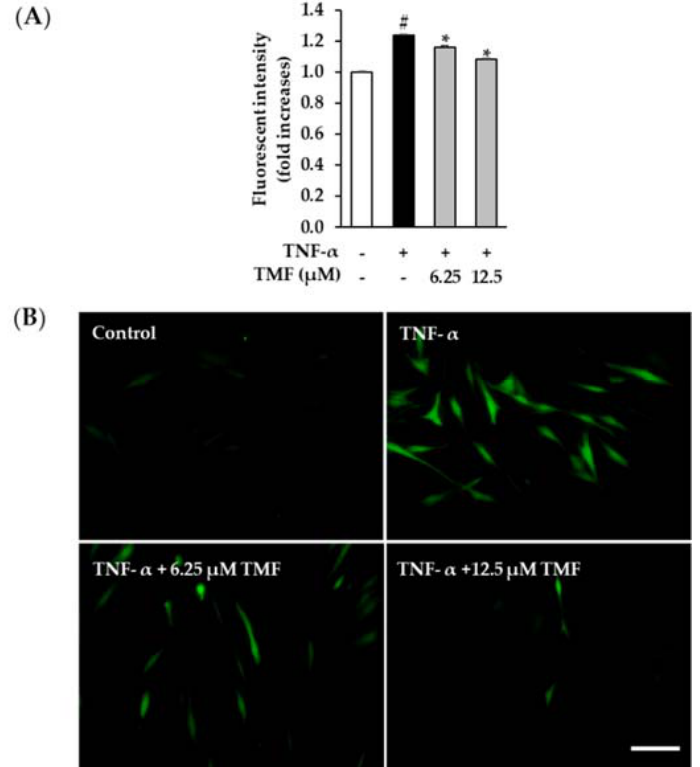
Figure 8. Inhibitory effect of TMF on ROS generation caused by TNF-α in NHDFs. ( A ) Briefly, 1 × 10 4 cells were seeded in 96-well plates and incubated for 24 h. The cells were continuously starved in serum-free DMEM for 24